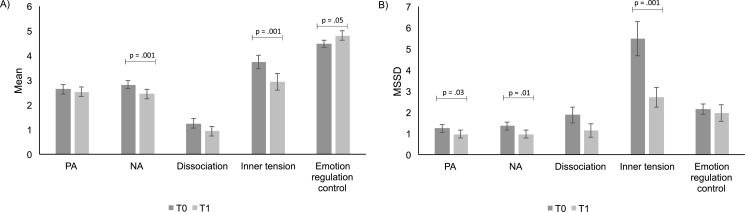
Ecological Momentary Assessment (EMA) data were assessed before (T0) and after (T1) neurofeedback training. A) Mean negative affect (NA) and inner tension significantly decreased, and perceived control over one's own emotions increased from T0–T1. Perceived control over one's own emotions was assessed with two items: asking how much participants felt they can control / cannot control their emotions now (see supplement for exact wording). Mean dissociation and positive affect (PA) did not significantly change from T0–T1. B) Mean squared successive differences (MSSD; i.e., hour-to-hour variability) of PA, NA, and inner tension significantly decreased from T0–T1, while the hour-to-hour variability of dissociation and perceived control over one's own emotions did not significantly change from T0–T1. Error bars represent standard error of the mean (SEM).